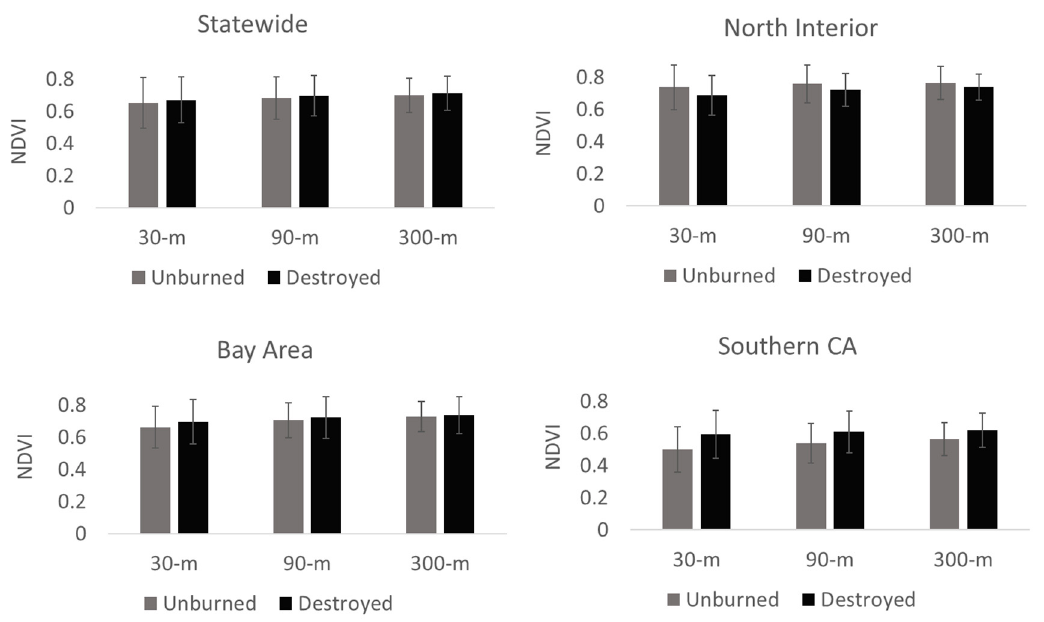
Figure 2. Mean NDVI in unburned and destroyed structures in wildfire perimeter statewide and in three regions of California. Error bars depict the standard deviation.